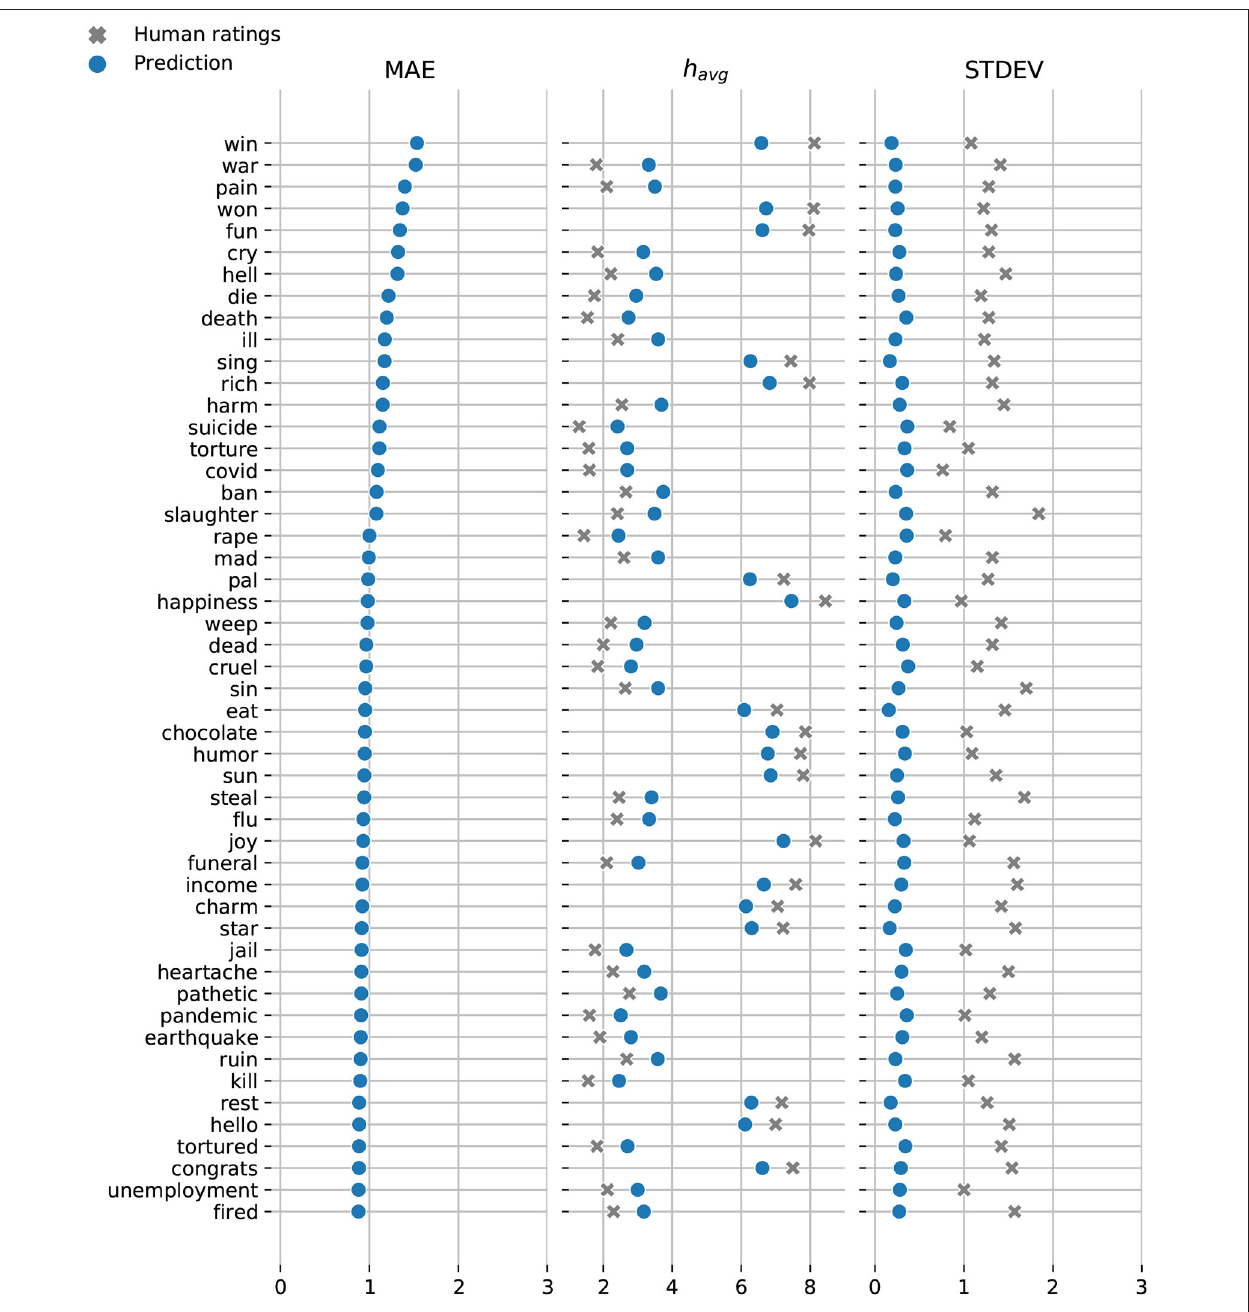
FIGURE 7 | Token model: Top-50 words with the highest mean absolute error. Model predictions are shown in blue and the crowdsourced annotations are displayed in gray. While still maintaining relatively low MAE, most of our predictions are conservative—marginally underestimating words with extremely high happiness scores, and overestimating words with low happiness